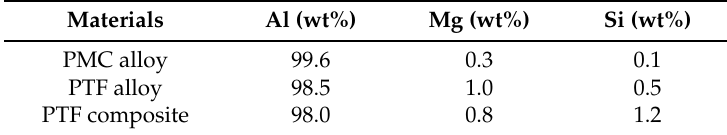
Table 1. Compositions of the primary α -Al particles or the grains of these